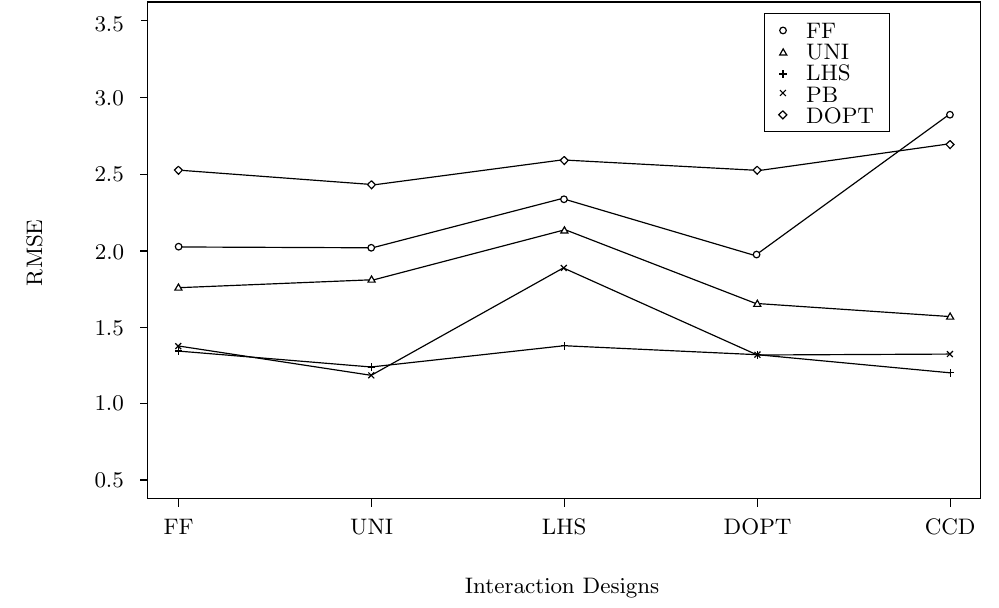
Figure 5: Plot of root mean square error (RMSE) values for the kriging model predictions (Screening designs: FF = Fractional Factorial Design, UNI = Uniform Design, LHS = Latin Hy- percube Design, DOPT = D-Optimal Design, CCD = Central Composite Design, PB = Plackett- Burman